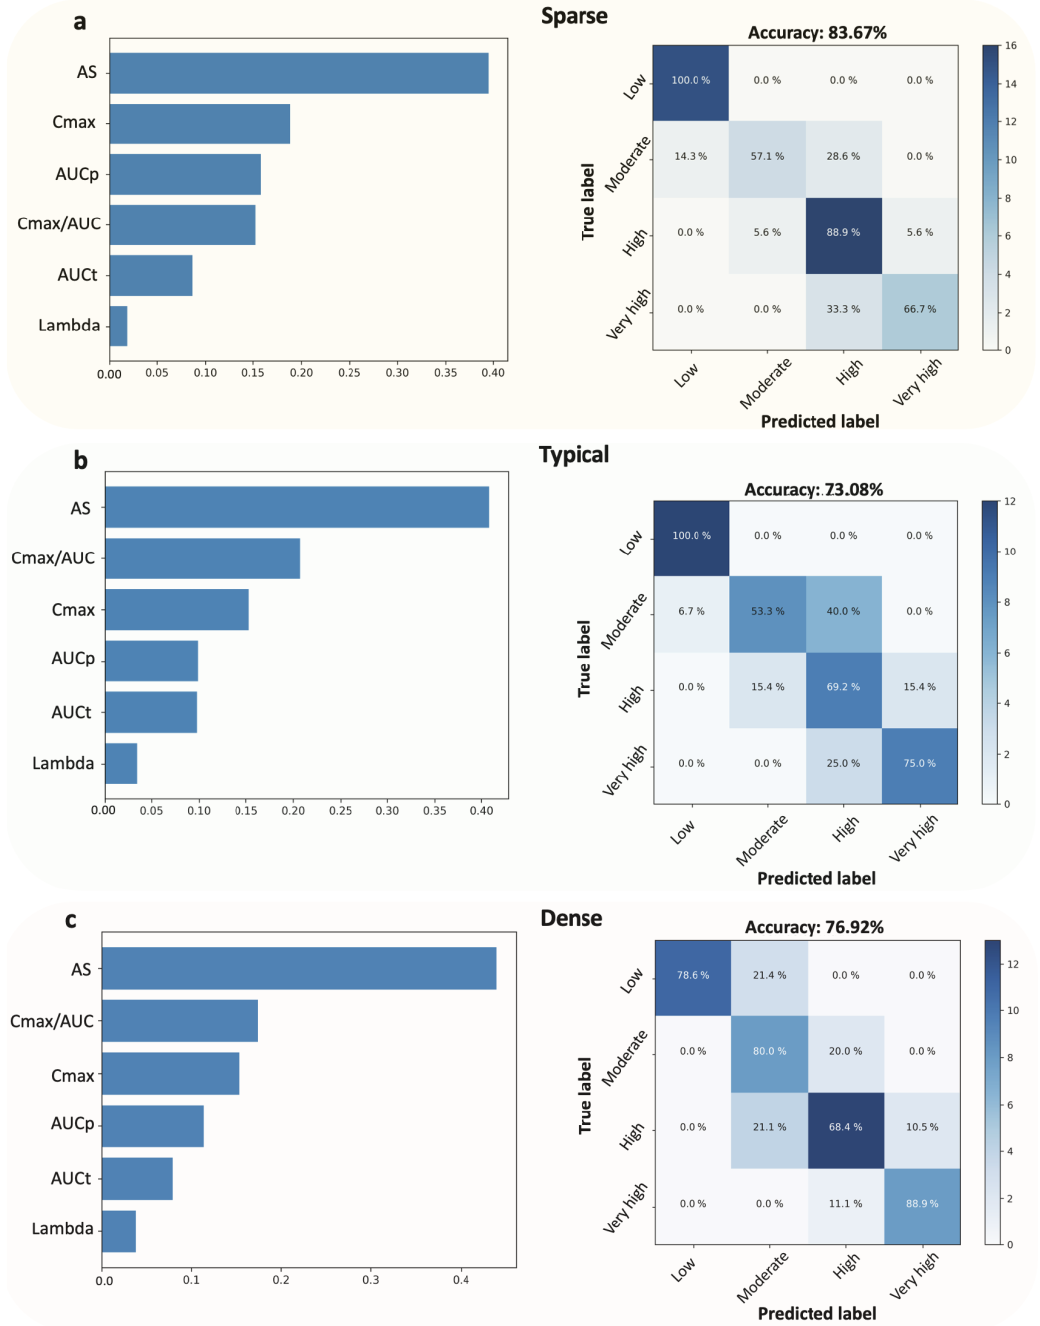
Figure 8. Variable importance scores and confusion matrices, in the case of simulated data, using Tmax as the response variable. The three separate random forest models developed correspond to sparse ( a ), typical ( b ), and dense ( c ) sampling schemes. The descriptors used for random forest models refer to the average slope (AS) ratio and other pharmacokinetic parameters listed in Table 1. The quartiles of the Tmax distribution were used to define its four categories.